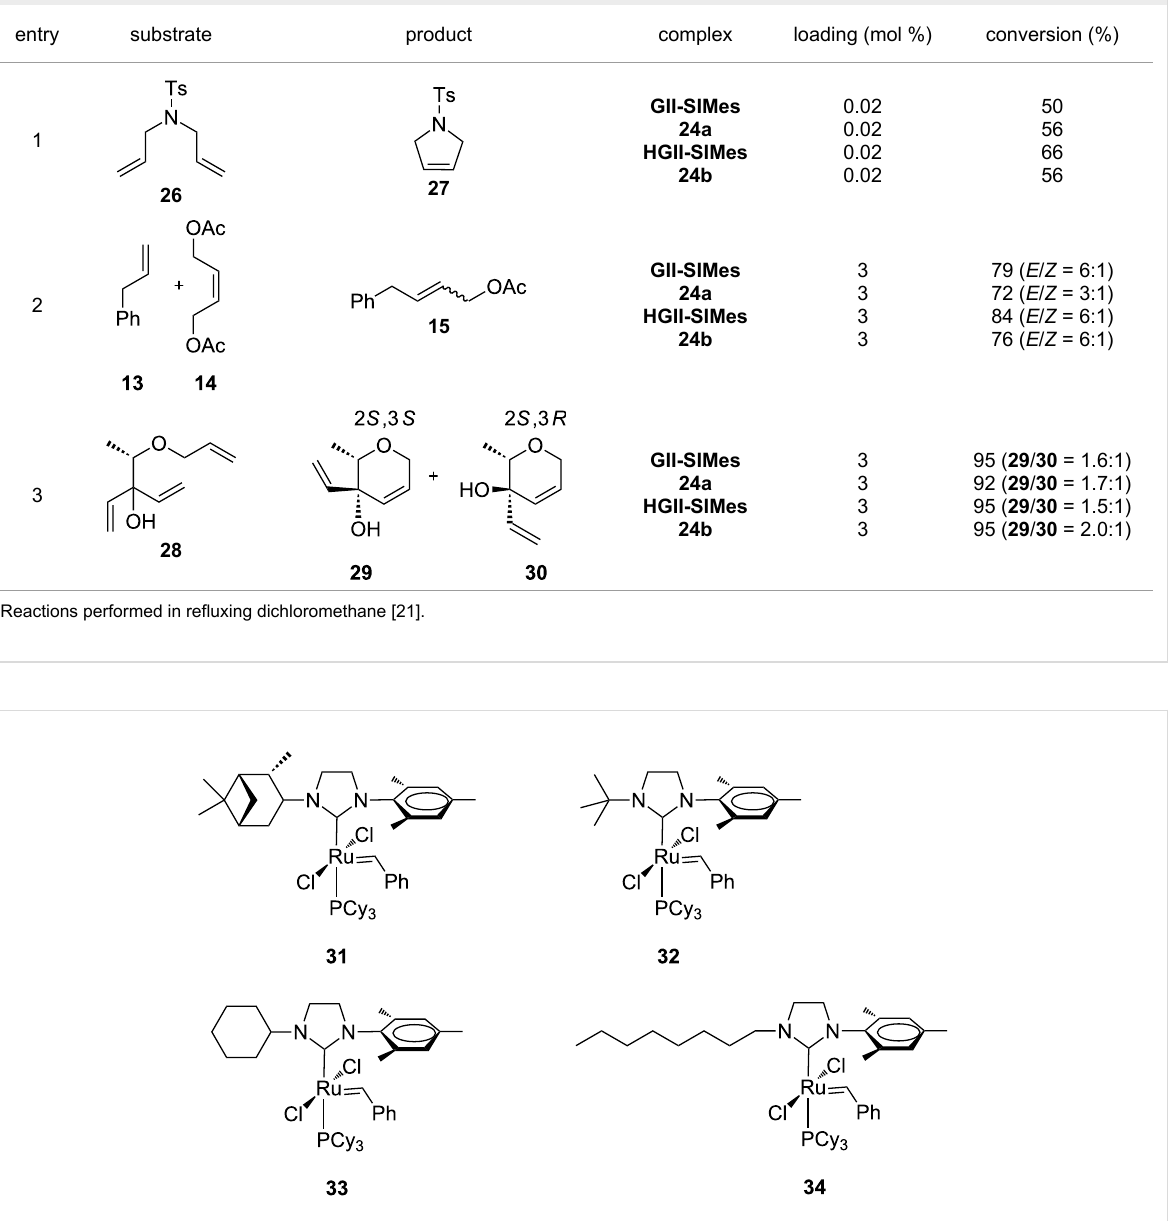
erably lower activity than the other tested catalysts. The replacement of the mesityl group by a 2,6-diisopropylphenyl group as in complexes 24a and 33 led preferentially to bis(NHC)-coordinated complexes, which showed metathesis ac- tivity only at elevated temperatures [23]. However, the mono(NHC) complex 35 (Figure 9) was isolated and tested in the RCM of 7 and the ROMP of cis -1,5-cyclooctadiene ( 16 ), where it displayed a fair olefin metathesis activity compared to the benchmark catalyst GII-SIMes